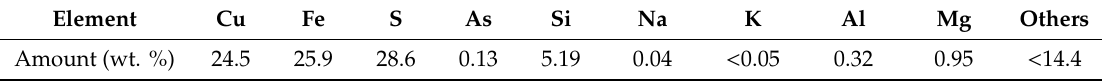
Table 1. Chemical composition of chalcopyrite concentrate as determined using ICP-AES. Element Cu Fe S As Si Na K Al Mg Others Amount (wt. %)